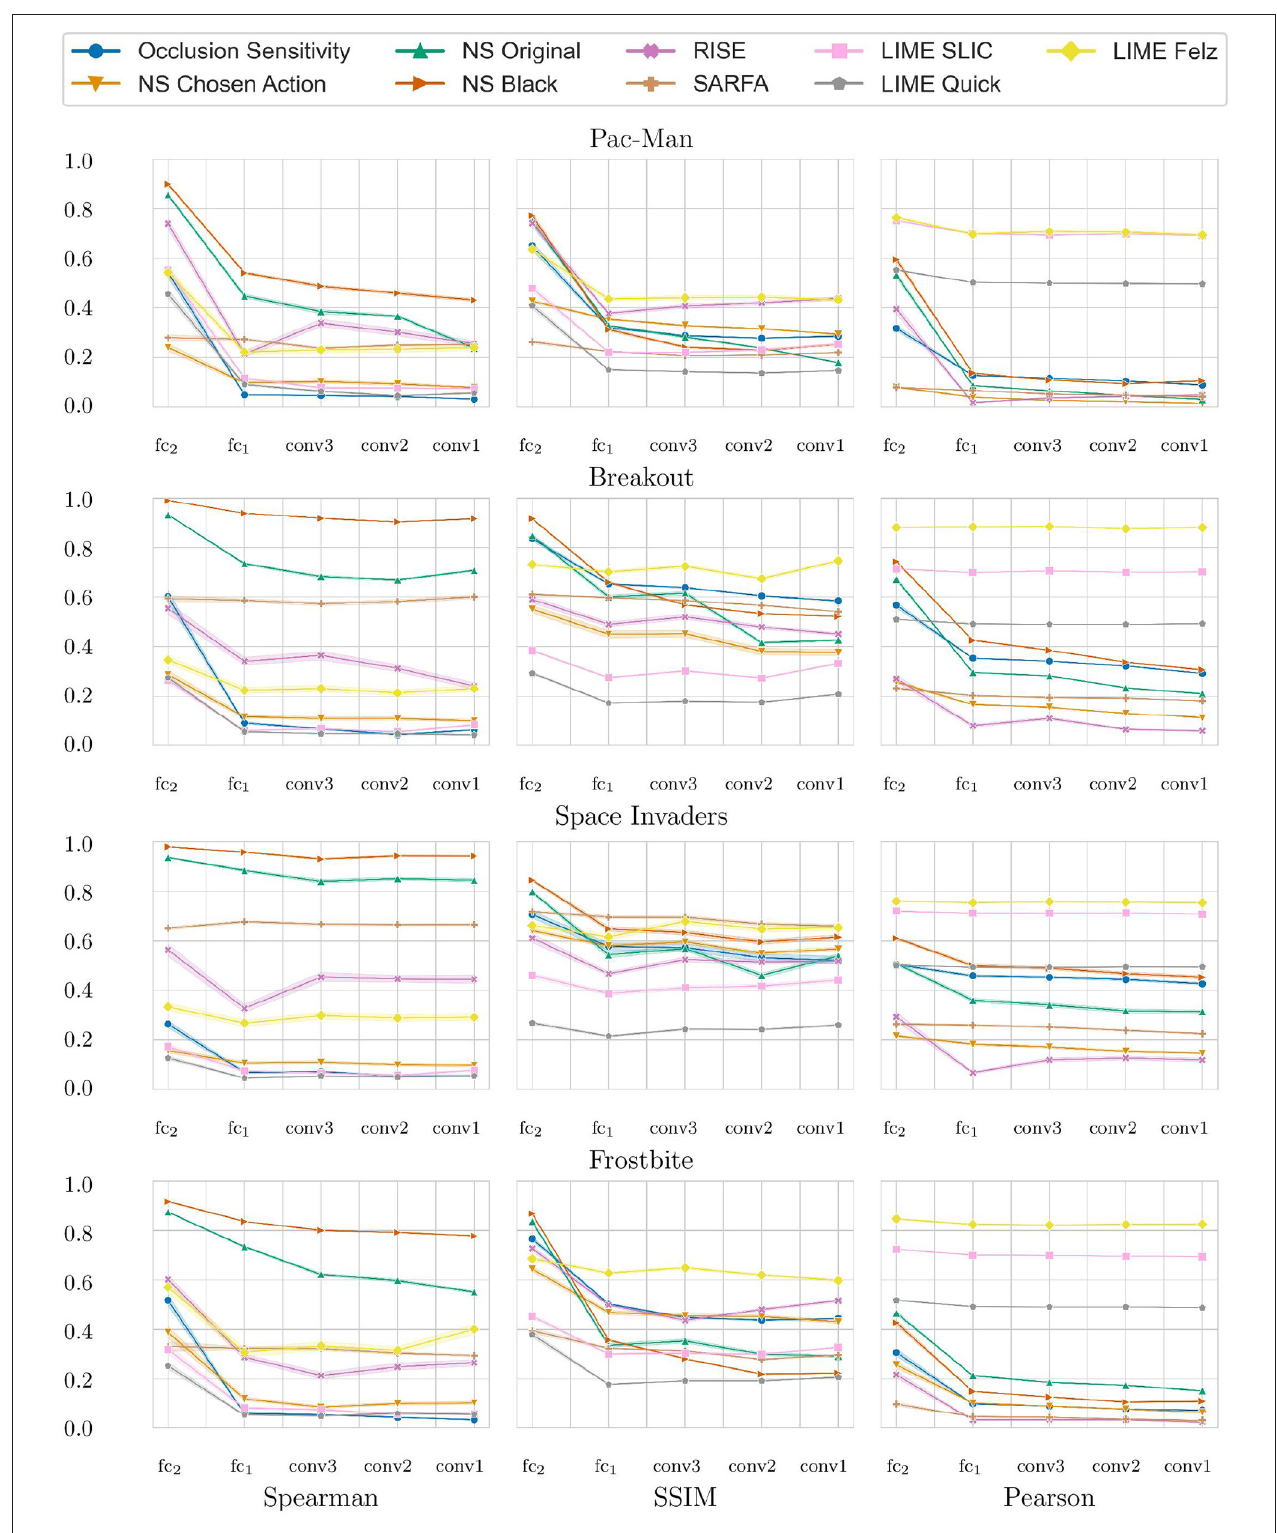
FIGURE 6 | Results of the sanity checks for each individual game for the different saliency map approaches ( NS is noise Sensitivity). Measured for 1,000 states of each of the 4 tested games. Starting from the left, each mark represents an additional randomized layer starting with the output layer. The y-axis shows the average similarity values (Spearman rank correlation, SSIM, Pearson correlation of the HOGs). High values indicate a low parameter dependence. The translucent error bands show the 99% CI.